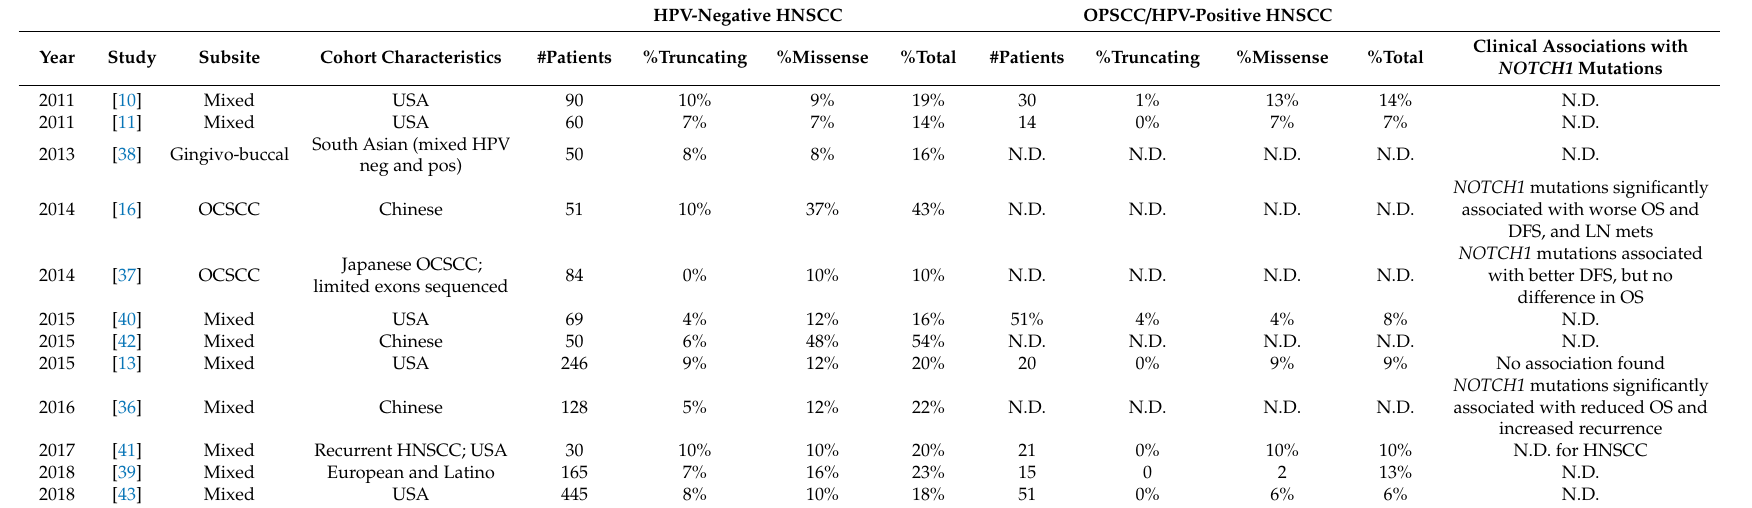
Table 1. Summary of NOTCH1 genomic